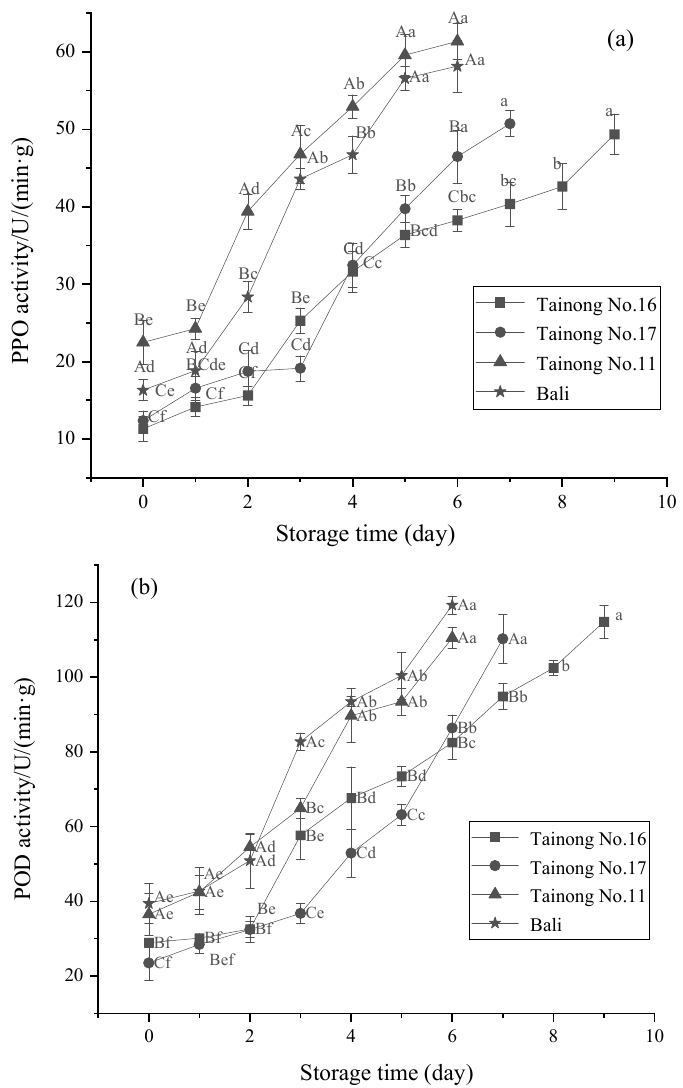
Figure 6. Changes of PPO activity ( a ) and POD activity ( b ) in freshly cut pineapple during storage. Different capital letters (A–C) indicate significant ( p < 0.05) differences in PPO activity and POD activity between varieties at the same storage time; different lowercase letters (a–f) indicate significant ( p < 0.05) differences in PPO activity and POD activity between the same varieties at different storage times.